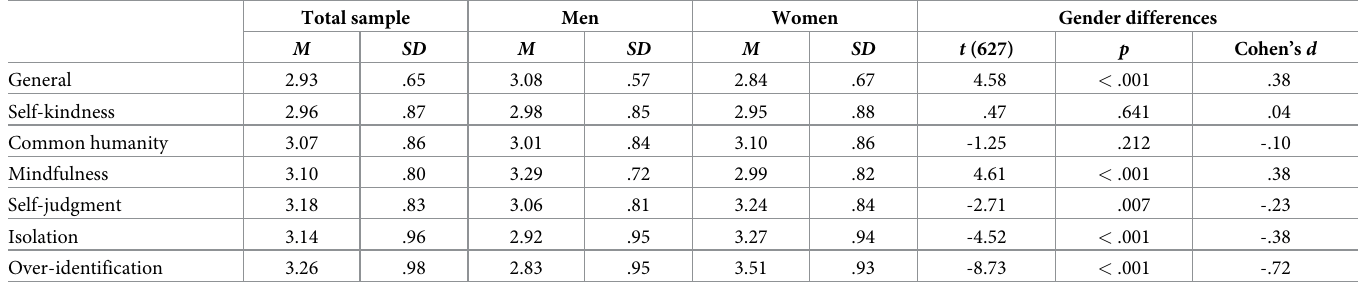
Table 6. Mean scores and gender differences in self-compassion.